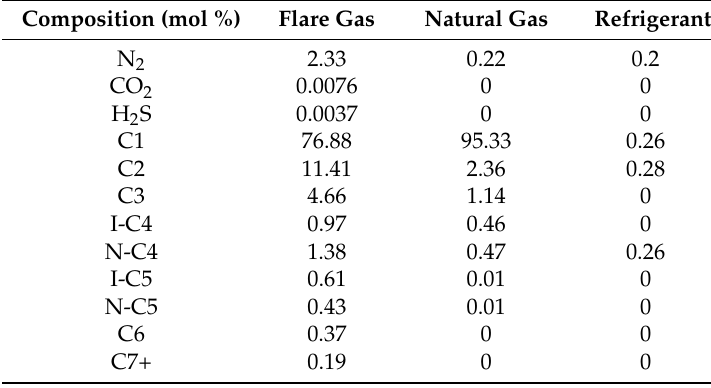
Table 1. Compositions of flare gas, natural gas, and refrigerant.